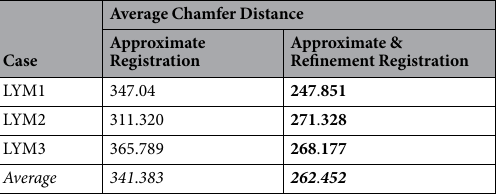
Table 2. A comparison of the registration of 10 slide lymph node cases before and after refinement. Registration quality is measured as the average Chamfer distance between the external boundaries of registered tissue sections. Slides were of the following markers: BCL2, BCL6, CAM5.2, CD3, CD5, CD10, CD20, Ki67, H&E, and Negative